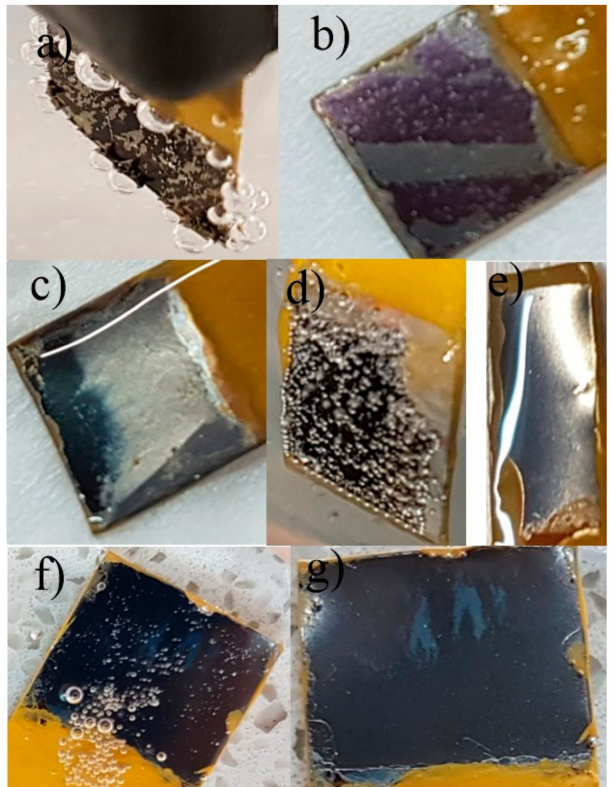
Figure 3. Macroscopic images of the TiO 2 samples electrochemically reduced at different conditions: ( a ) sample A during the reduction at 5 V for 60 min in a 1:1 glycerol–water solution with 0.27 wt.% NH 4 F, ( b ) sample B reduced at 5 V for 5 min in a 1:1 glycerol–water solution with 0.27 wt.% NH 4 F after its removal from the electrolyte, ( c ) sample C reduced at 5 V for 5 min in a 3:1 glycerol–water solution with 0.13 wt.% NH 4 F after its removal from the electrolyte, ( d ) sample E during the